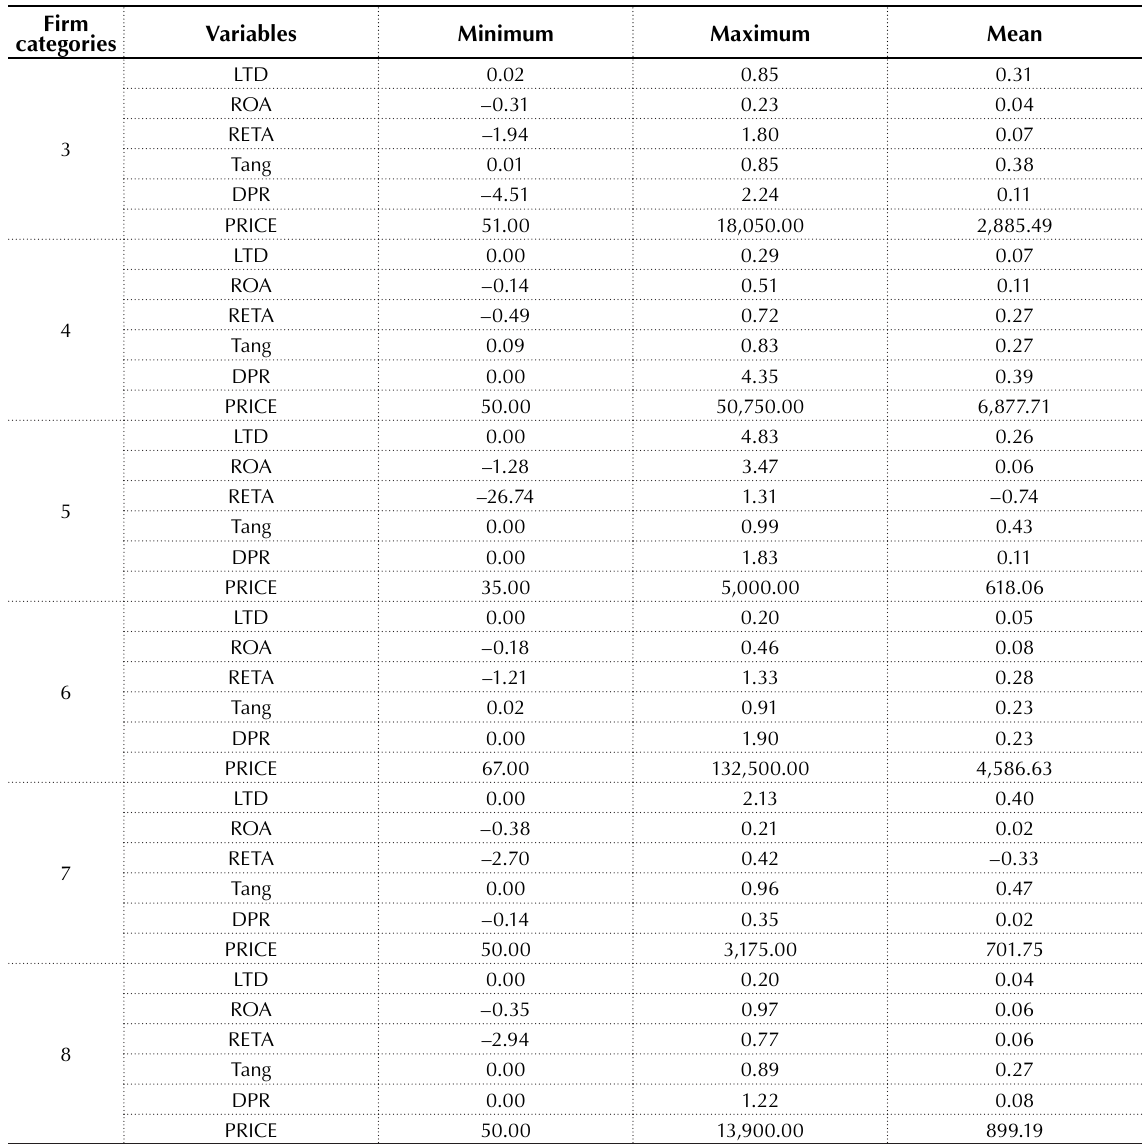
Table 3 (cont.). Descriptive